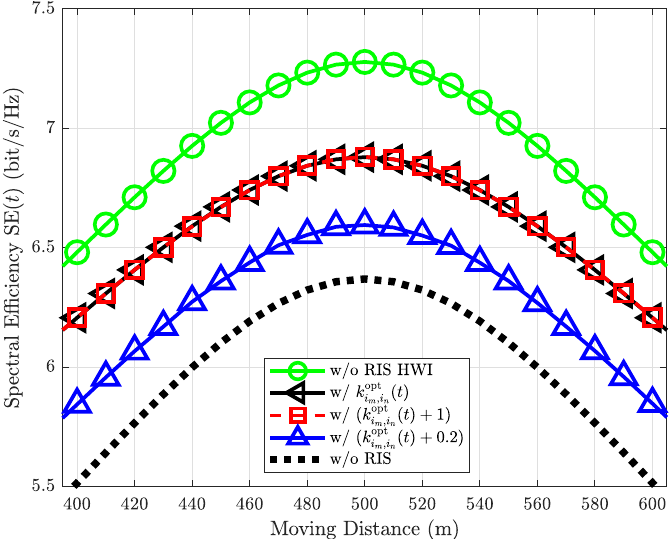
Figure 3. Spectral efficiency for the system using different phase shift sets. K = 8.